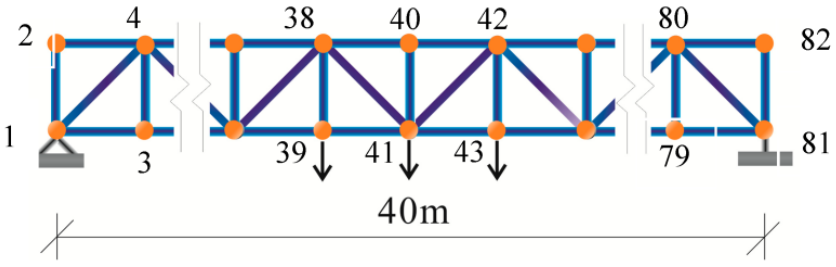
Figure 4. Truss Figure 4. Truss structure.